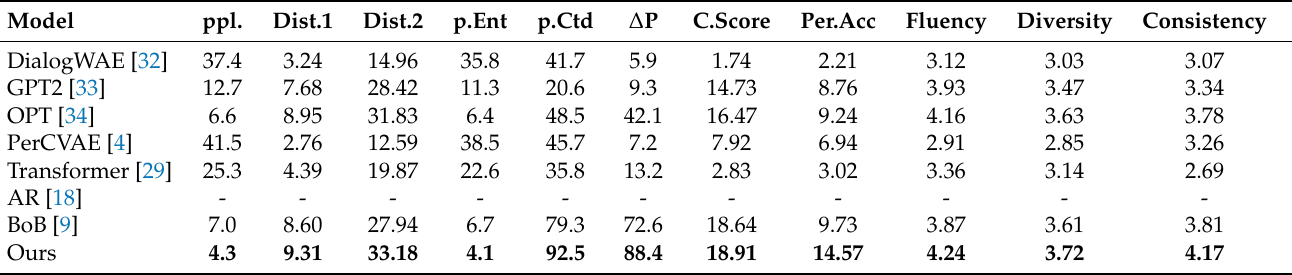
Table 3. Experiment results of PersonaChat